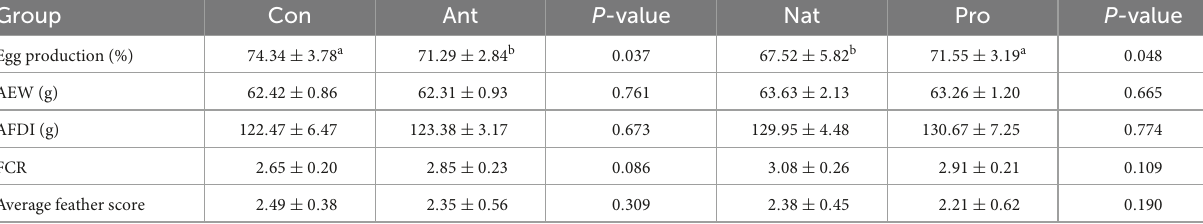
TABLE 4 Effect of different dietary treatments on feather-pecking principal coordinates (36.9% of overall variation) with statistical behavior in laying hens. significance ( F = 5.866, P = 0.001). Also, significant differences in OTU levels were observed between Pro group and Nat Behavior Treatment Class Chi-square group ( F = 2.235, P = 0.012), although the Pro group cluster statistic was not completely separated from the Nat group. Further (NMDS) demonstrated that the genus level of the microbial communities was also significantly divided into 2 groups by antibiotic or probiotic treatment ( Figure 2C ). Analyzing the bacterial populations at the phylum level showed that the cecum of Con birds was dominated by Bacteroidetes (58.91%; Figure 2D ), Firmicutes (29.72%), Proteobacteria (4.56%), and minority populations (6.81%) such as Actinobacteria (0.84%), Synergistetes (0.62%), and Fusobacteria (0.11%). Antibiotic treatment significantly expanded the Proteobacteria (11.40%, P < 0.001; Figure 2D ) at the expense of Firmicutes (26.43%, P < 0.05) and others (2.27%, P < 0.001). Interestingly, we found that probiotic treatment significantly reduced the abundance of Proteobacteria (5.68% VS. 2.38%, P < 0.001; Figure 2D ), while increasing the abundance of Firmicutes (37.14% VS. 41.17%, P <0.05) compared to the Nat group hens. At the genus level, the Bacteroides , Faecalibacterium , Lactobacillus , Desulfovibrio , Ruminococcus , Phascolarctobacterium , Prevotella , Parabacteroides , and Oscillospira accounted for the largest proportion of the microbiota (Relative abundance > 1%, Figure 2E ). The abundance of Desulfovibrio (2.31% VS.